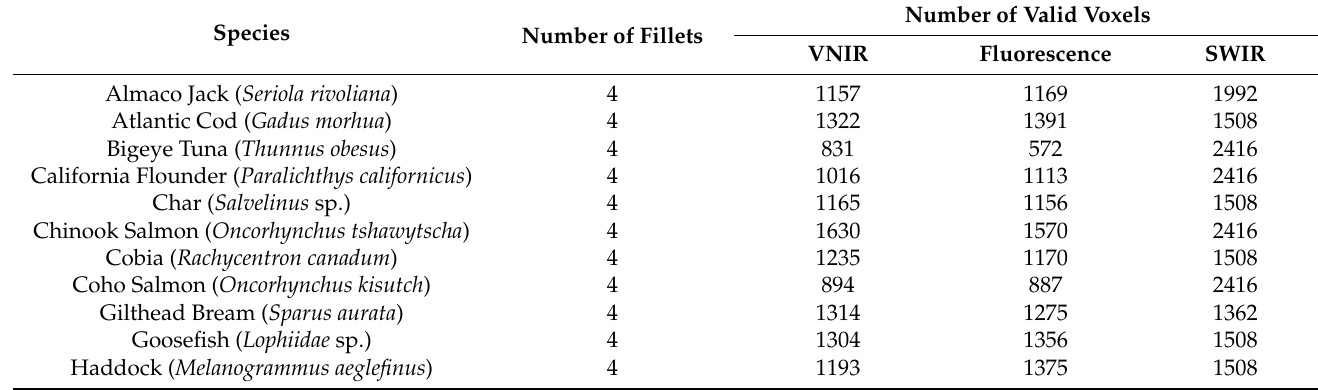
Figure 3. Overview of the data acquisition and processing flow. Table 1. Fish fillet database